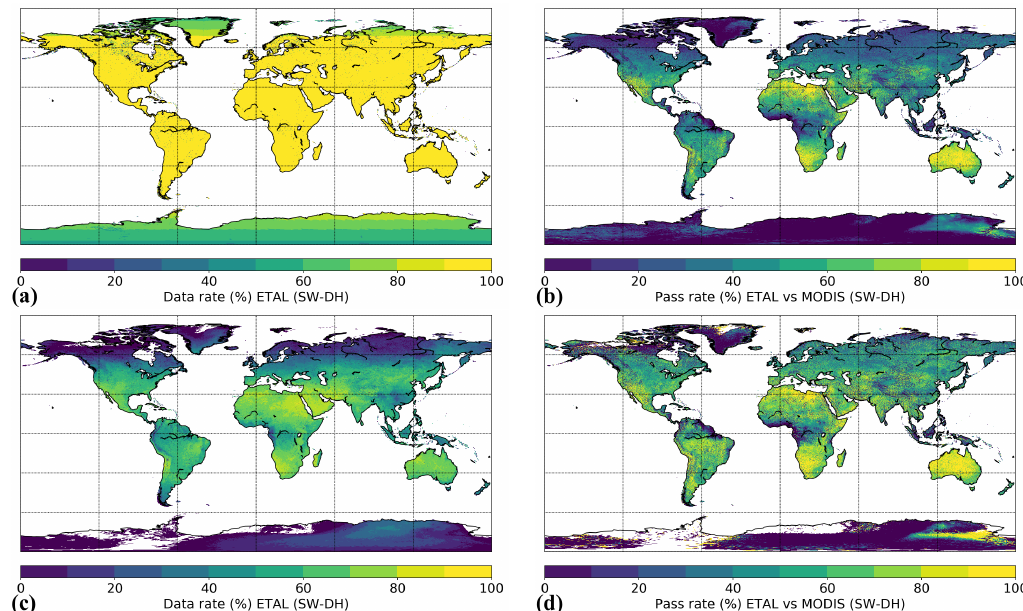
Figure 15. Mean yearly ETAL data rate and ETAL pass rate with respect to MODIS over the period 2015–2018: ( a , b ) before pre-processing the data (filtering on the quality flag and other criteria); and ( c , d ) after filtering. The white color indicates the absence of data (either missing in ( a , b ) or filtered at the preprocessing step in ( c , d )).